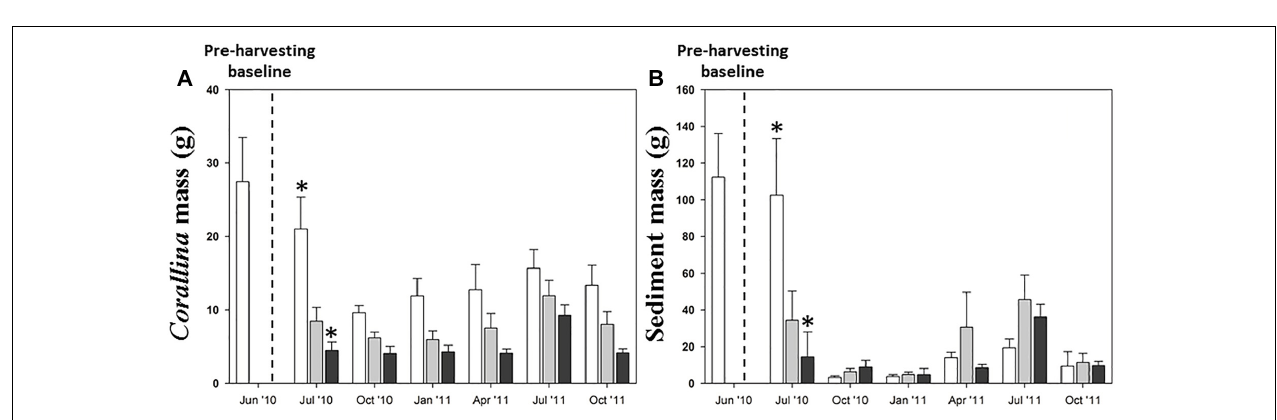
FIGURE 6 | Abundances plotted by harvesting method and month for the six groups with large Harvest × Month interaction effects (Dev = > 20, Table 2 ). Effect of harvesting seen in all groups in the first month after harvest (July 2010). Extreme outliers are indicated on the plots. Note differing scales on y axes. Control, unshaded; Cut, light gray; Pull, dark gray. Line, median value; Box, 1st and 3rd quartiles; Whiskers, values falling within 1.5 × range of quartiles; outliers are represented by open circles, extreme outlier values are marked.